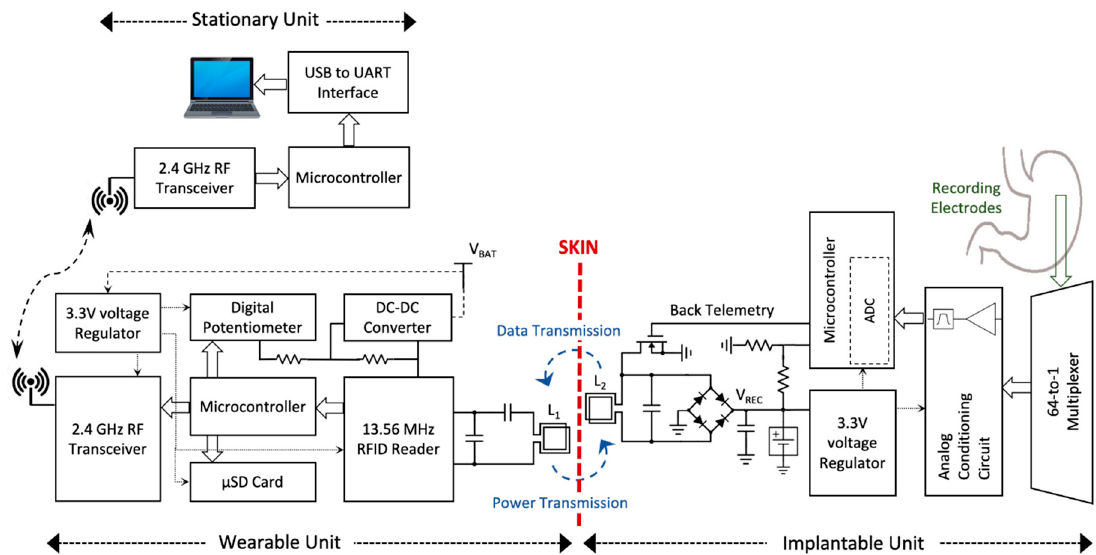
Figure 5. The detailed block diagram of the system consisting of the implantable, wearable and stationary units for near-field communication and wireless power transfer is presented.